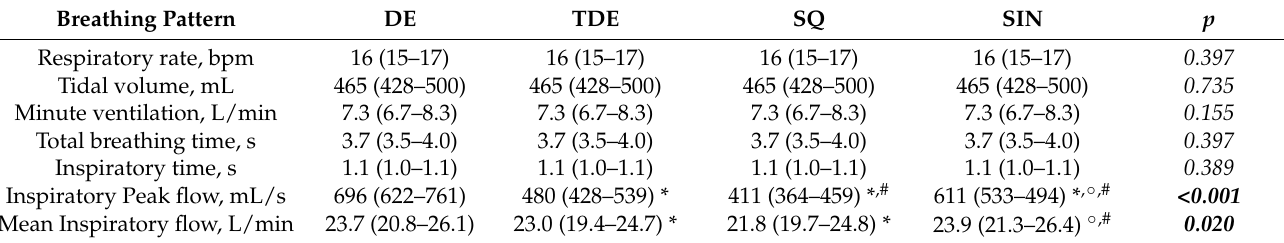
Table 2. Breathing pattern according to flow waveforms.